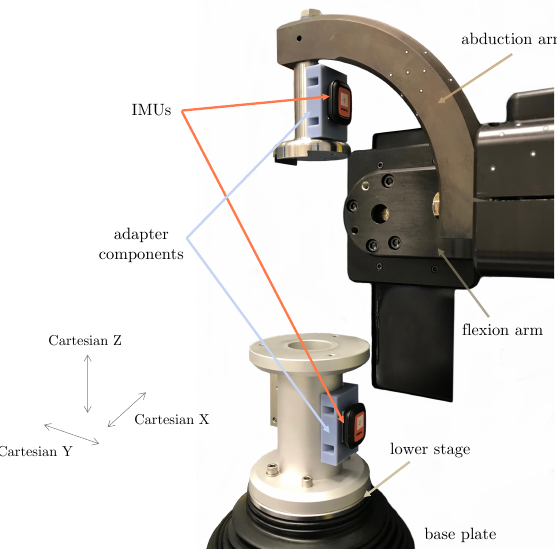
Figure 2. Two inertial sensors were attached to the joint simulator (shown here in reference pose) using mounting adhesive tape: one was attached to the condylar adapter component (top), and the other to the tibial adapter component (bottom). Custom rapid prototype adapters (in blue) were developed to ensure both sensors could be easily adhered onto a flat